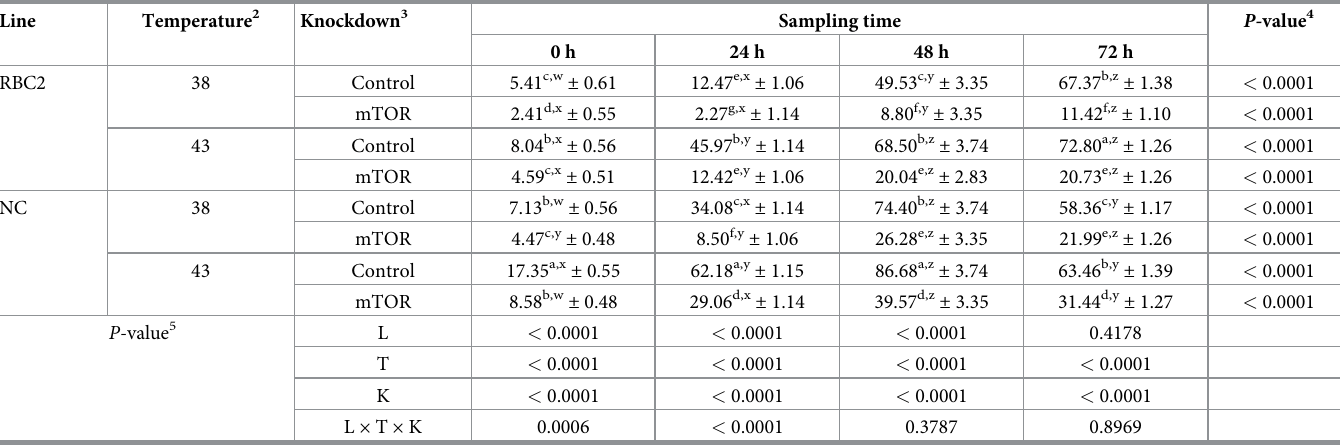
Table 4. Effect of heat stress (43˚C) and knockdown of mTOR at the beginning of proliferation on RBC2 and NC line SC differentiation 1 .